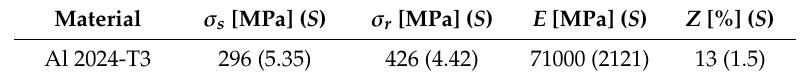
Table 2. Mechanical properties of Al 2024 T3.